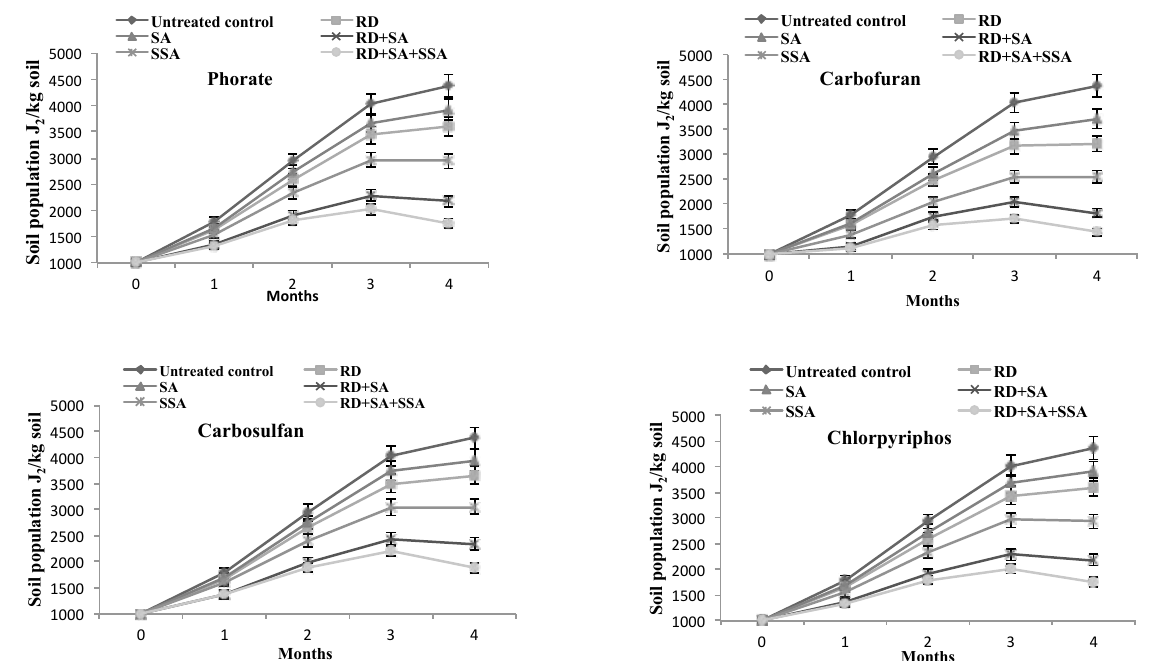
Figure 1. Mean soil populations of Meloidogyne graminicola (J2 kg-1 soil) at 1, 2, 3, 4 (harvest) months after transplanting rice plants and different nematicide treatments. RD: Root Dip, SA: Soil Application 15 days after transplanting, SSA: Second Soil Application 30 days after transplanting. Error bars are showing standard error. Points marked by different letters are different (P≤0.001) according to Duncan’s Multiple Range Test